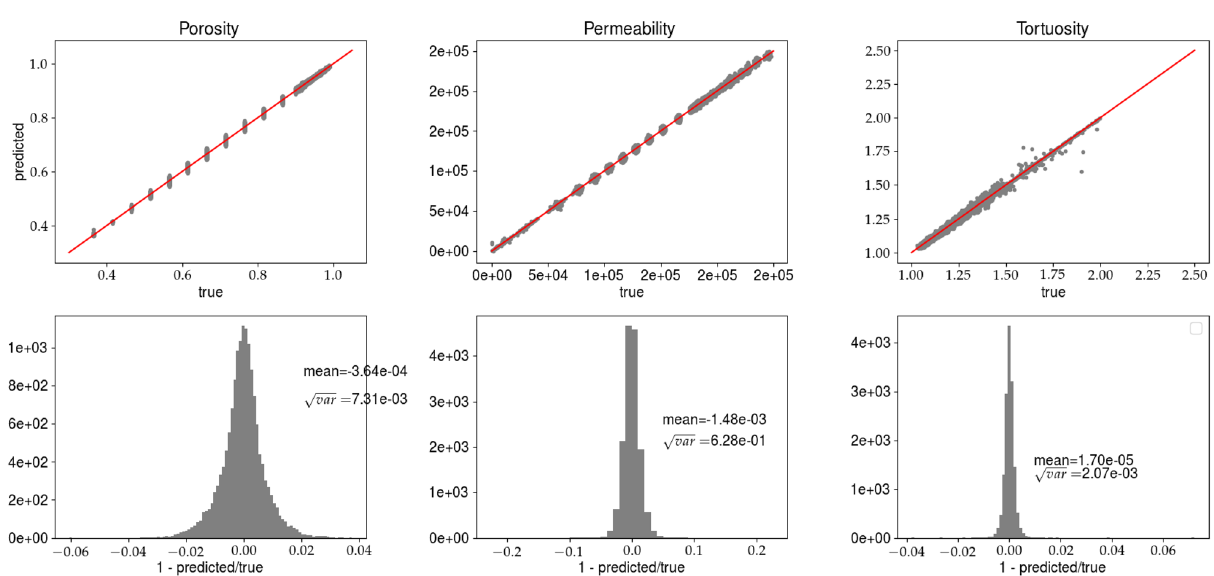
Figure 8. Caption the same as in Fig. 7 but the predictions are made for the validation data